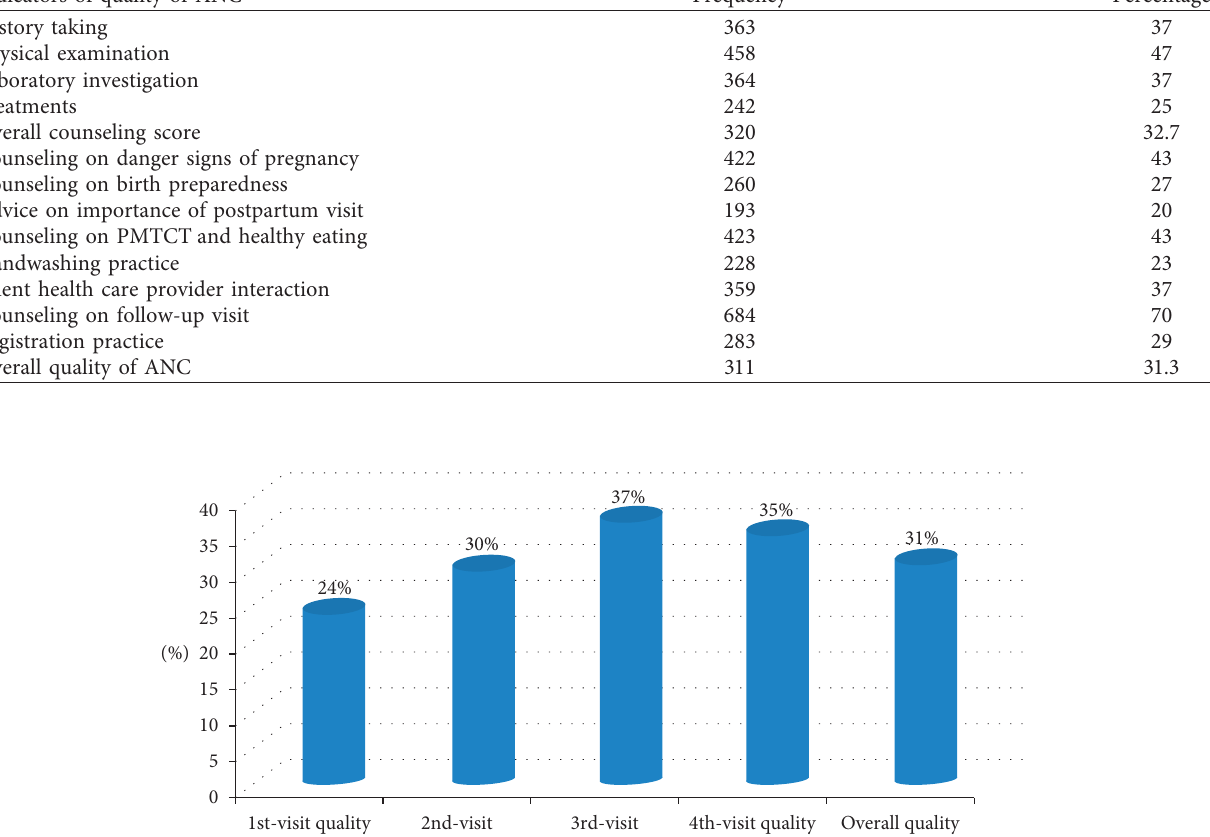
Table 1: Summary of the dimensions of good quality of antenatal care during all ANC visits of the study participants ( n � 980) observed at Hossana Town’s public health facilities, Southern Ethiopia, July 2017 to June 2018. Indicators of quality of ANC